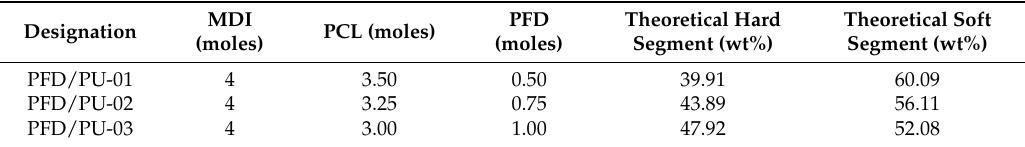
Table 1. Recipe and theoretical phase compositions of the PFD/PUs. MDI, 4,4 (cid:48) -diphenylmethane diisocyanate; PCL, polycaprolactone